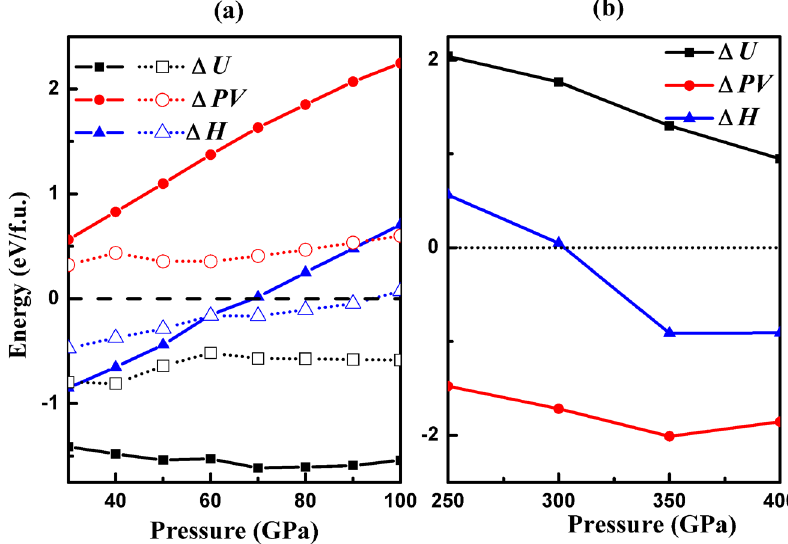
Fig. 6 Calculated Δ H , Δ U , and Δ ( PV ) for 1:4-H 2 S-NH 3 phases as a function of pressure. a Low pressure phases P2 1 /m (solid lines) and I4/m (dotted lines). b High pressure P-1 phase. Both graphs are relative to the decomposition reaction 4NH 3 + (2H 3 S +